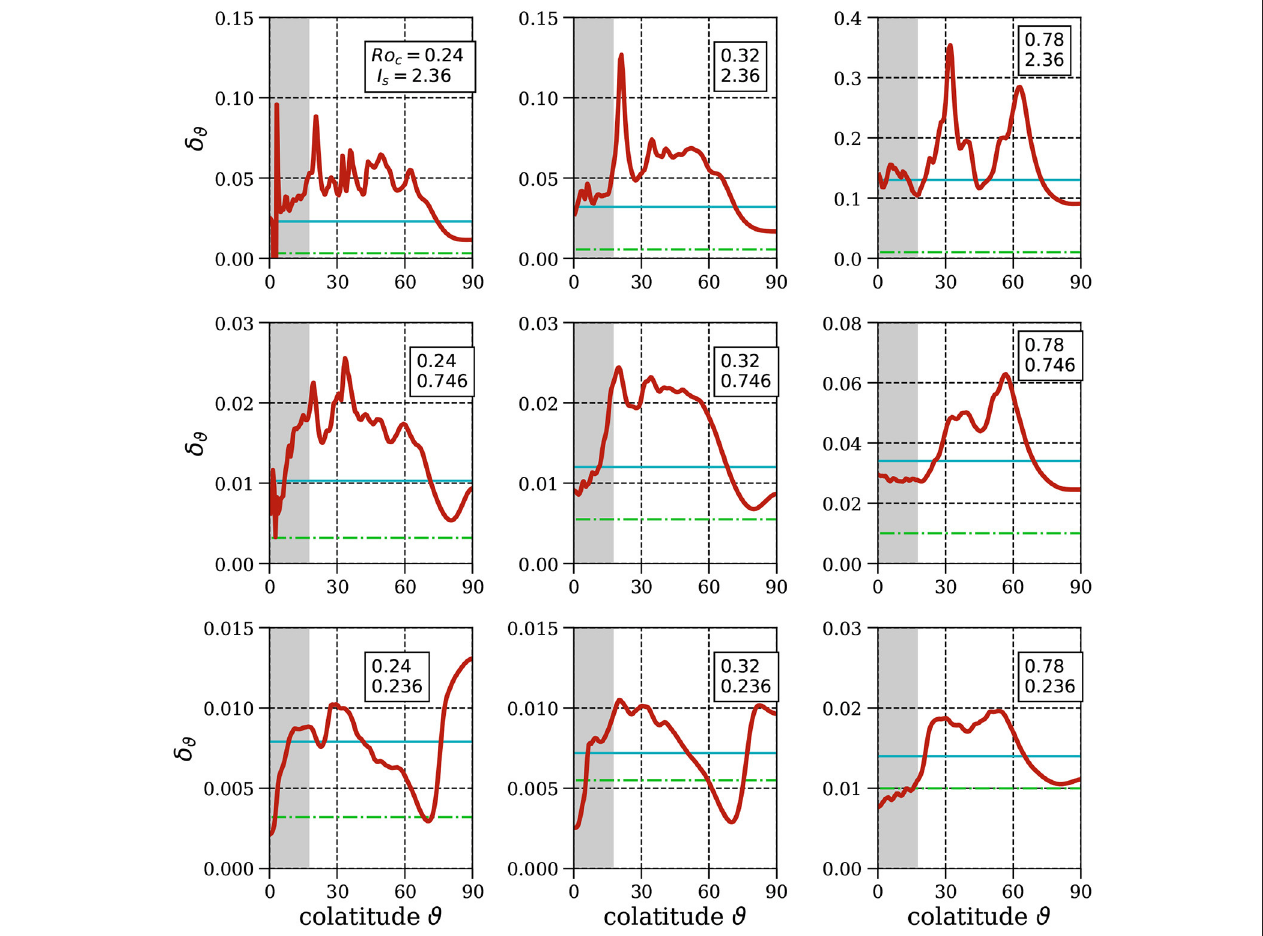
r lb . The green = r i / r lb . =